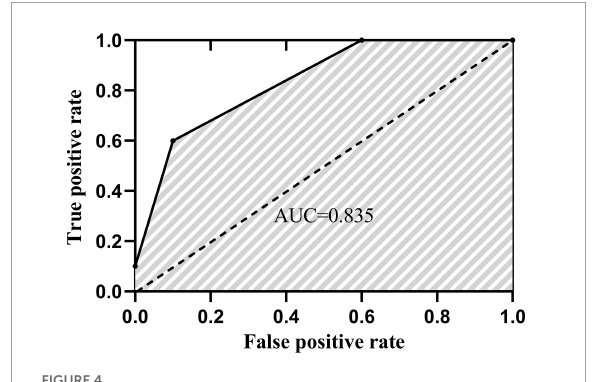
FIGURE4 One participant example of the area under a ROC